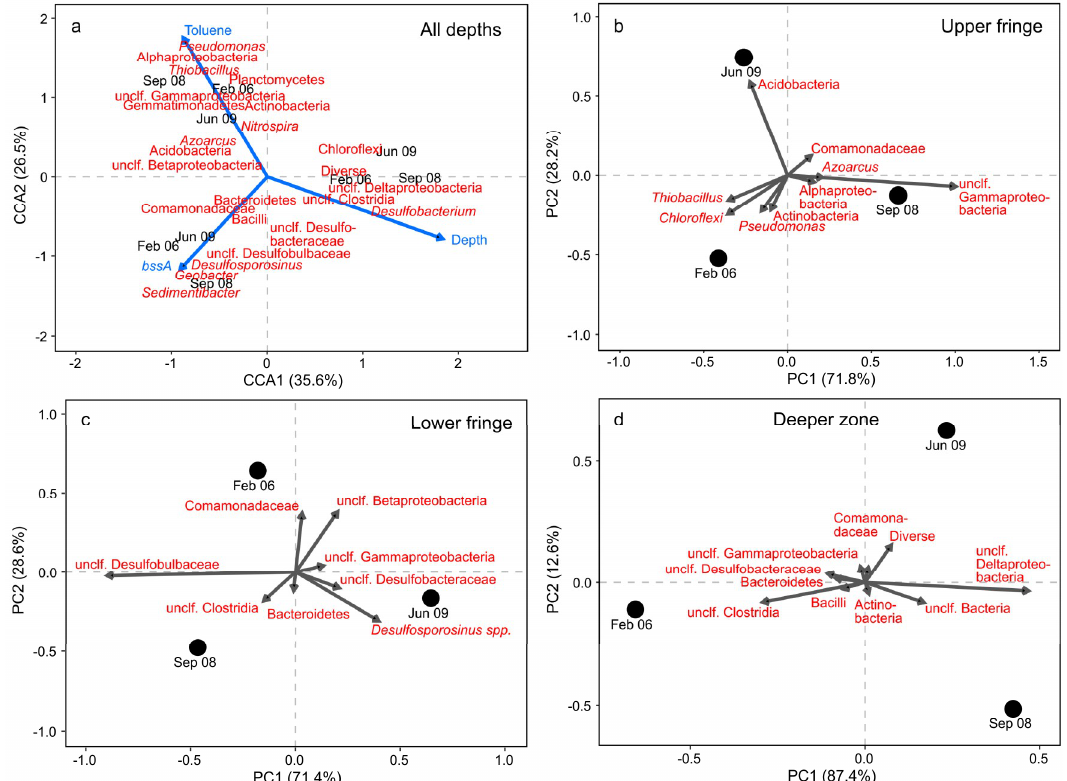
Figure 5. ( a ) Canonical correspondence analysis (CCA) triplot of overall samples (black), sequencing OTUs (red), and explanatory variables (blue) analyzed in this study. The proportion of inertia explained by the constrained model was 66.1% of which 62.1% was retained in the first two axes. Significance of CCA axes and explanatory variables (1000 permutations): CCA1 ( p = 0.013); CCA2 ( p =0.035); toluene concentration ( p = 0.009), depth below surface ( p = 0.008), bssA gene copy numbers ( p = 0.025). ( b – d ) PCA biplots showing changes of relative OTU abundances for individual plume zones over the years. All OTUs resolved in sequencing were included in statistical analysis, but for clarity of display, only vectors of OTUs with a combined loading of >1% on the first two principle components are shown.